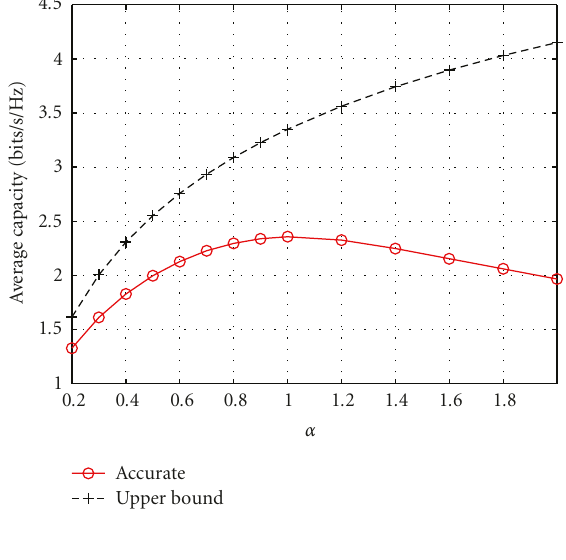
Figure 6: Eigenvalue moments versus various α in the low β